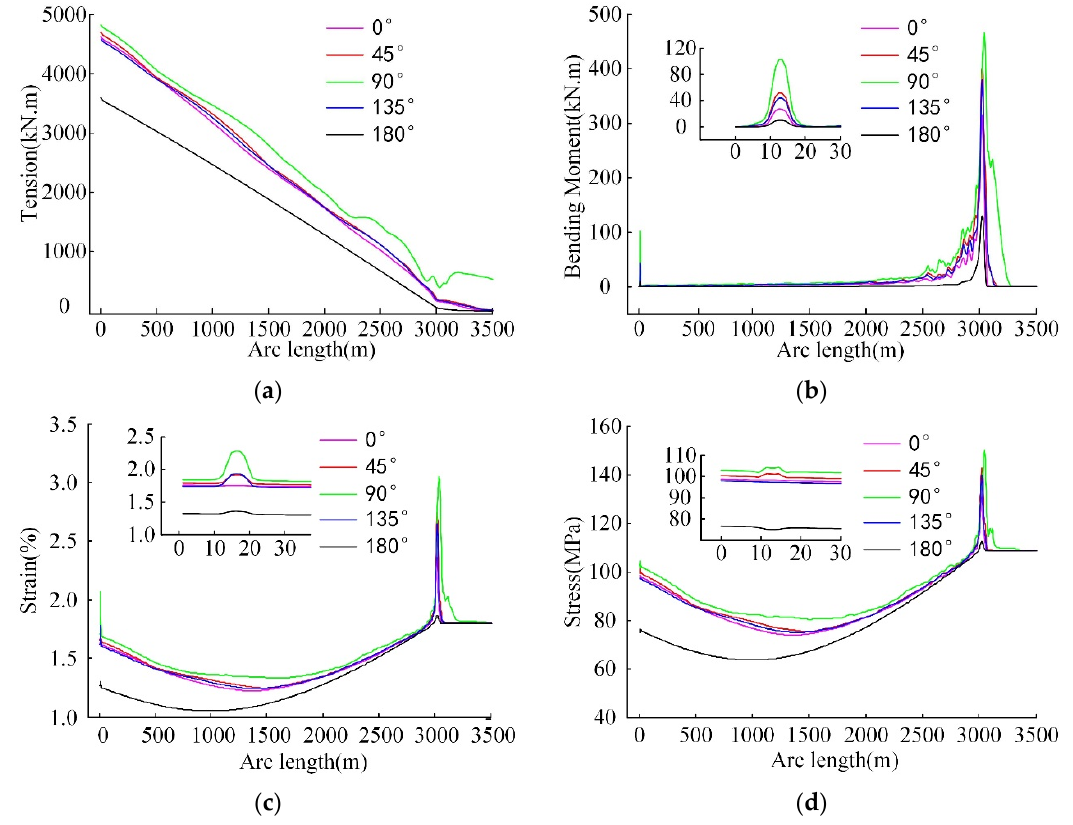
Figure 10. Effect of wave heading on pipeline dynamic responses: ( a ) Axial tension; ( b ) Bending moment; ( c ) Strain; ( d ) Stress.